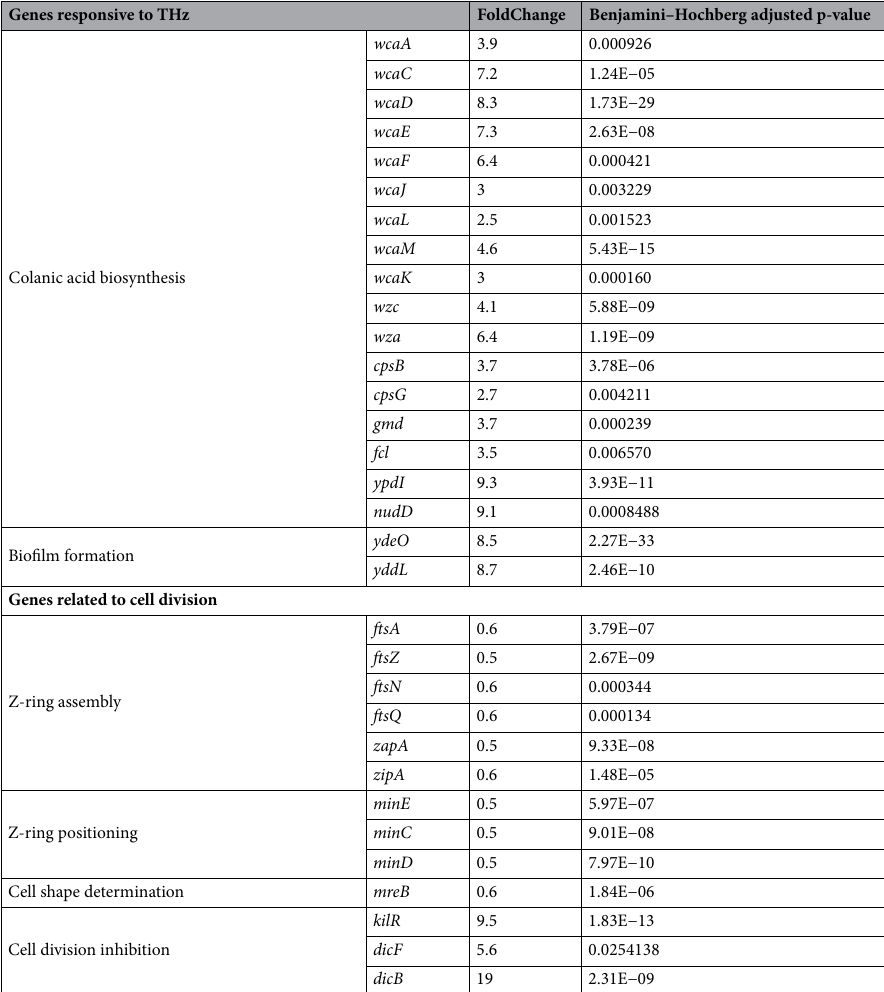
Table 1. Terahertz radiation–induced changes in the expression of the genes responsible for the biosynthesis of pili and of colanic acid as well as the genes that control cell